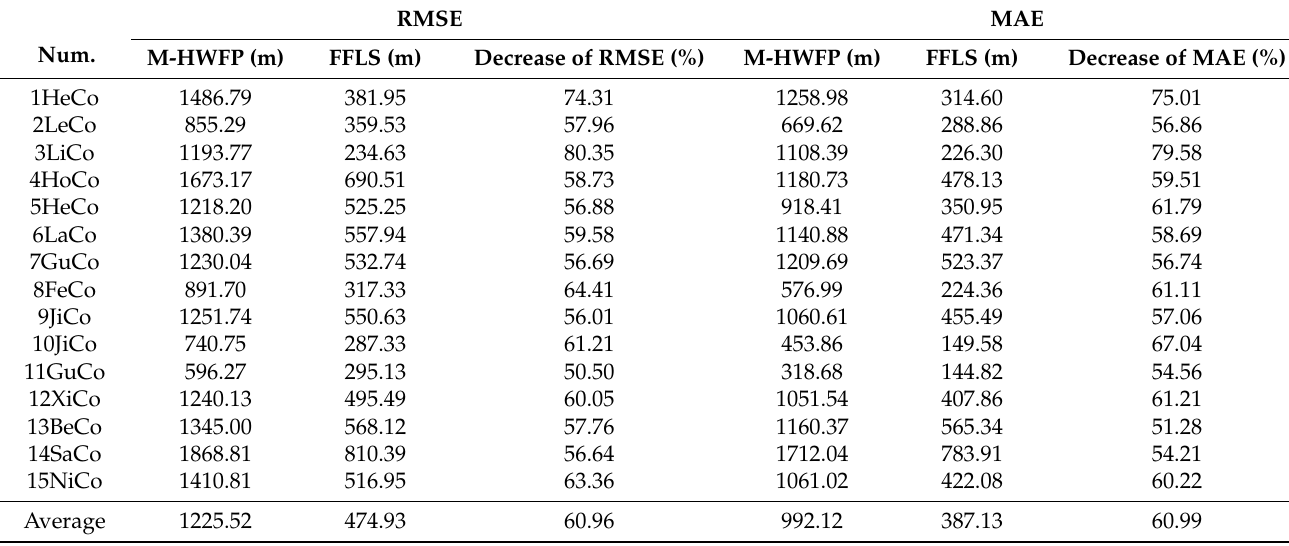
Table 3. Accuracy comparison of M-HWFP and